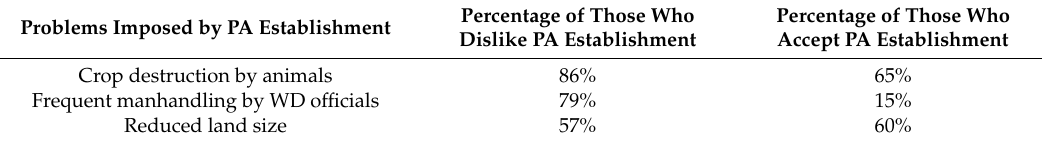
Table 4. Problems Imposed by PA Establishment and Community Attitudes towards PA